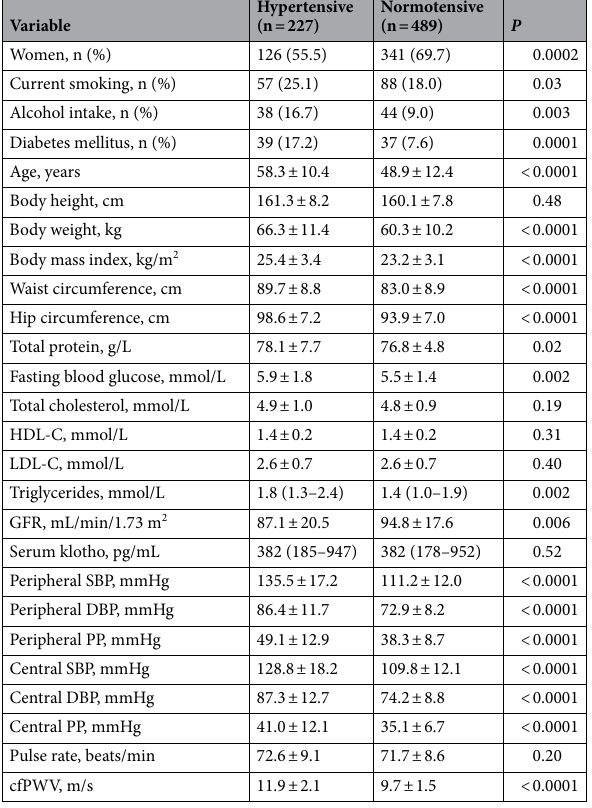
Table 2. Characteristics of the study population stratified by the hypertension status. Values are presented as means ± standard deviations, medians (interquartile ranges), or numbers (%). cfPWV carotid–femoral pulse wave velocity, DBP diastolic blood pressure, GFR glomerular filtration rate, HDL-C high-density lipoprotein cholesterol, LDL-C low-density lipoprotein cholesterol, PP pulse pressure, SBP systolic blood